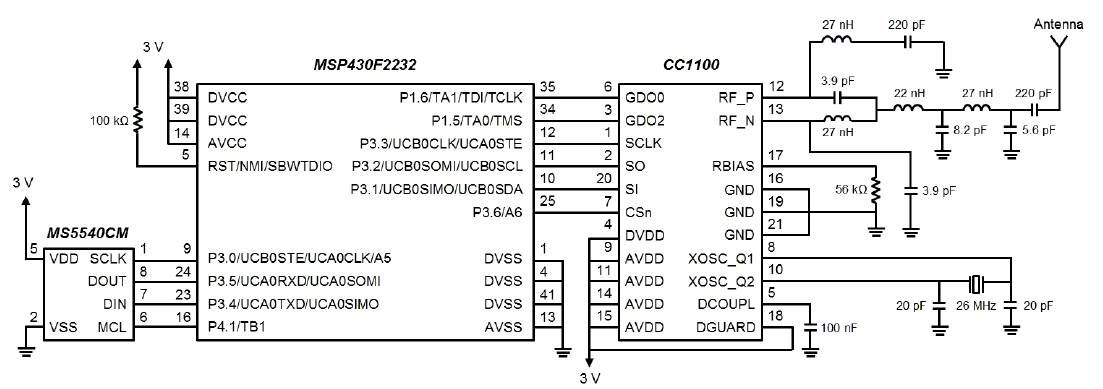
Figure 2. Overall schematic diagram of the wireless pressure measurement biomicrosystem.